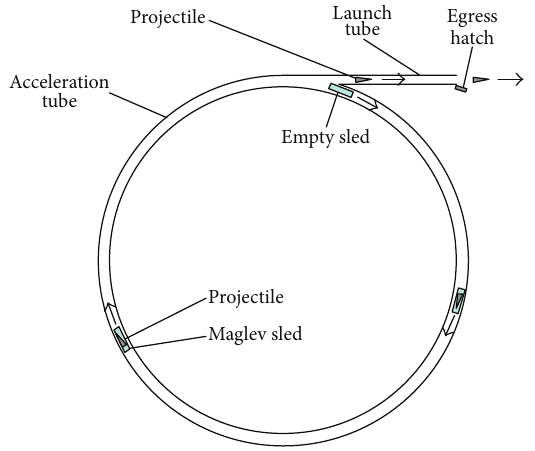
Figure 17: General launch-ring